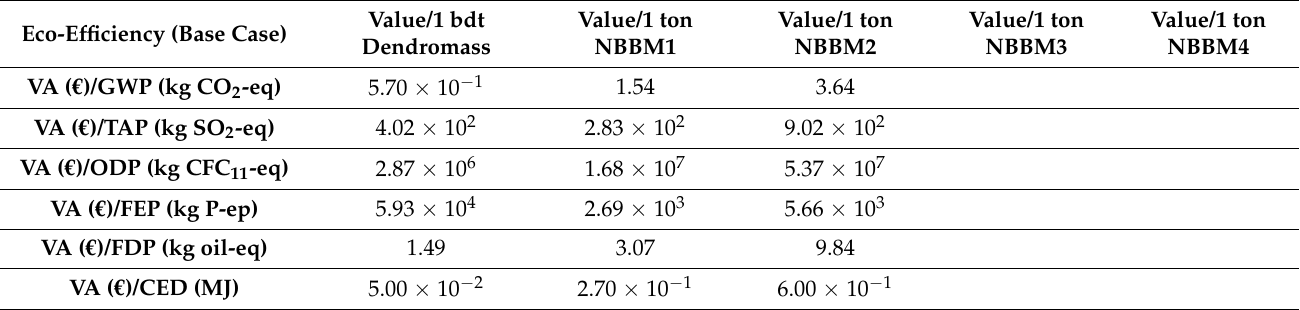
Table 4. Eco-efficiency based on value added by the production of dendromass and NBBM1–4 per ton of product (Base Case).